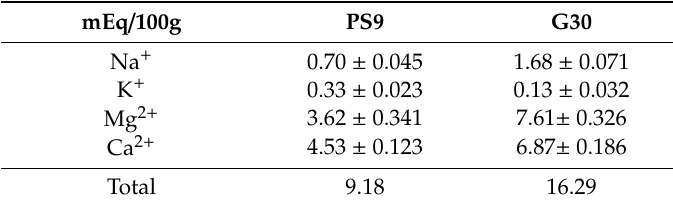
Table 5. CEC results of PS9 and G30 (average mEq / 100 g ± s.d.; n =